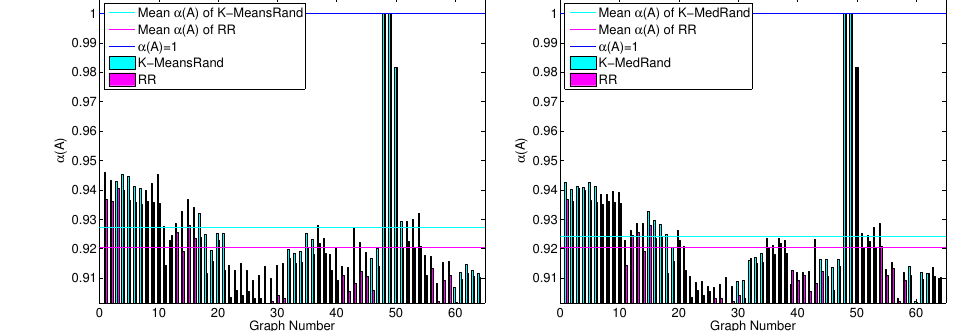
( c ) Comparison of α ( A ) for K-MeansRand and RR. ( d ) Comparison of α ( A ) for K-MedRand and RR.